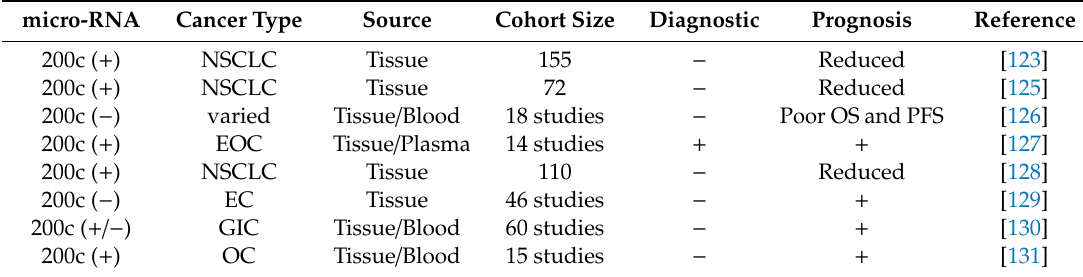
Table 4. Elevated ( + ) or reduced ( − ) miRNA-200c levels are shown, as are the cancer types, source of materials the miRNA was detected from and the patient cohort size. NSCLC, non-small cell lung cancer; EOC, epithelial ovarian cancer; GIC, gastrointestinal cancer; esophageal cancer (ES); OC, ovarian cancer. The negative or positive use of the technique in diagnostic or prognostic evaluation of patients are denoted by − or + ,